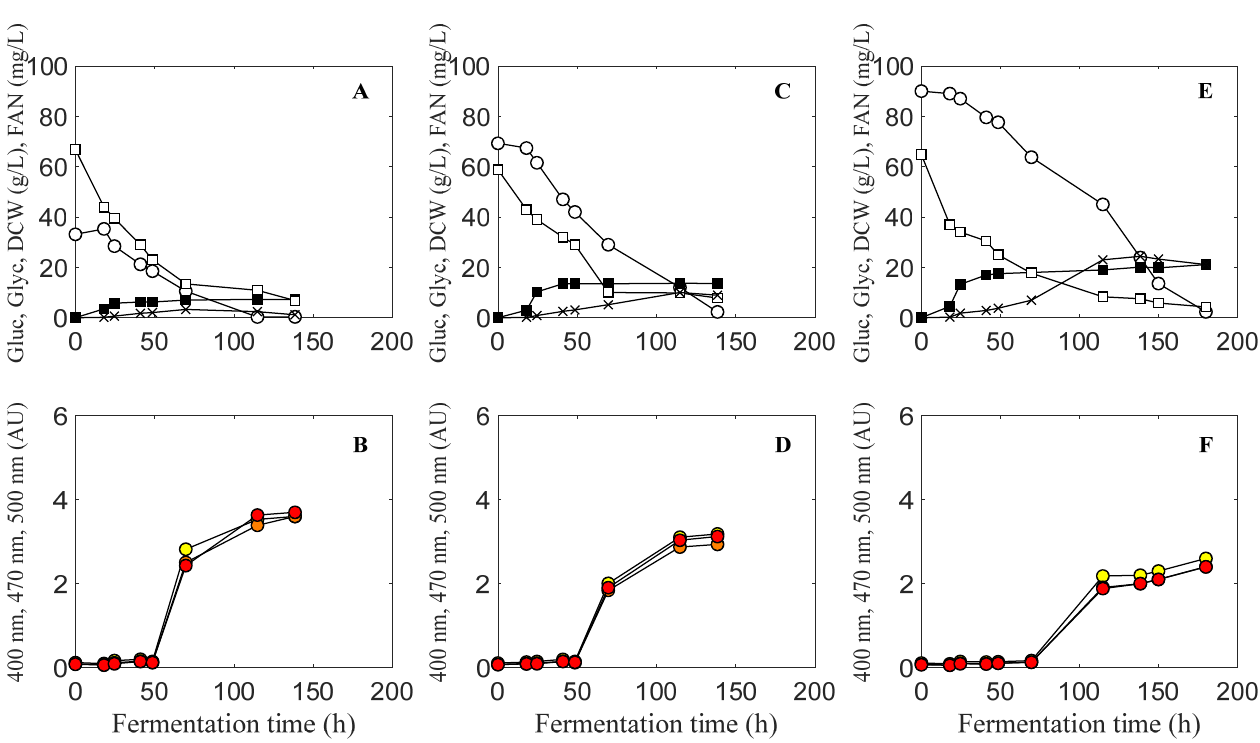
Figure 1. Glucose and free amino nitrogen (FAN) consumption and fermentation product accumulation at different initial sugar concentrations of 30 g/L ( A , B ), 60 g/L ( C , D ) and 90 g/L ( E , F ). Glucose (o). FAN ( □ ). DCW ( ■ ). Glycerol (×). Absorbance at 400 nm ( ). Absorbance at 470 nm ( ). Absorbance at 500 nm ( ).